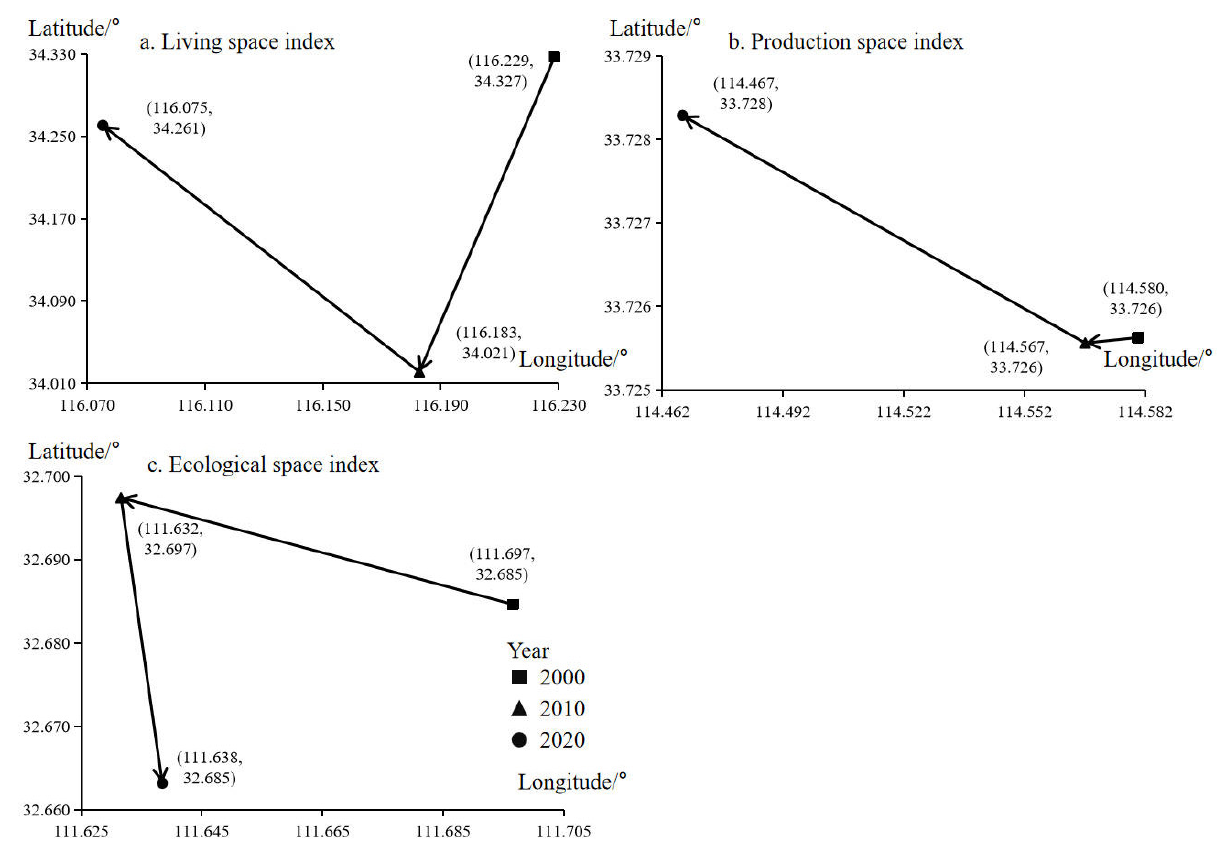
Figure 4. Evolution trajectory of PLES index gravity centers in China during 2000–2020.